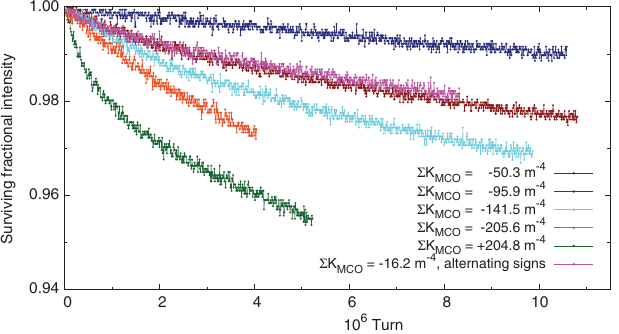
FIG. 5. Relative beam intensity vs turns plotted for all octupolar configurations probed in the LHC DA experiment with Beam 1. The different intensity decay rate is visible.